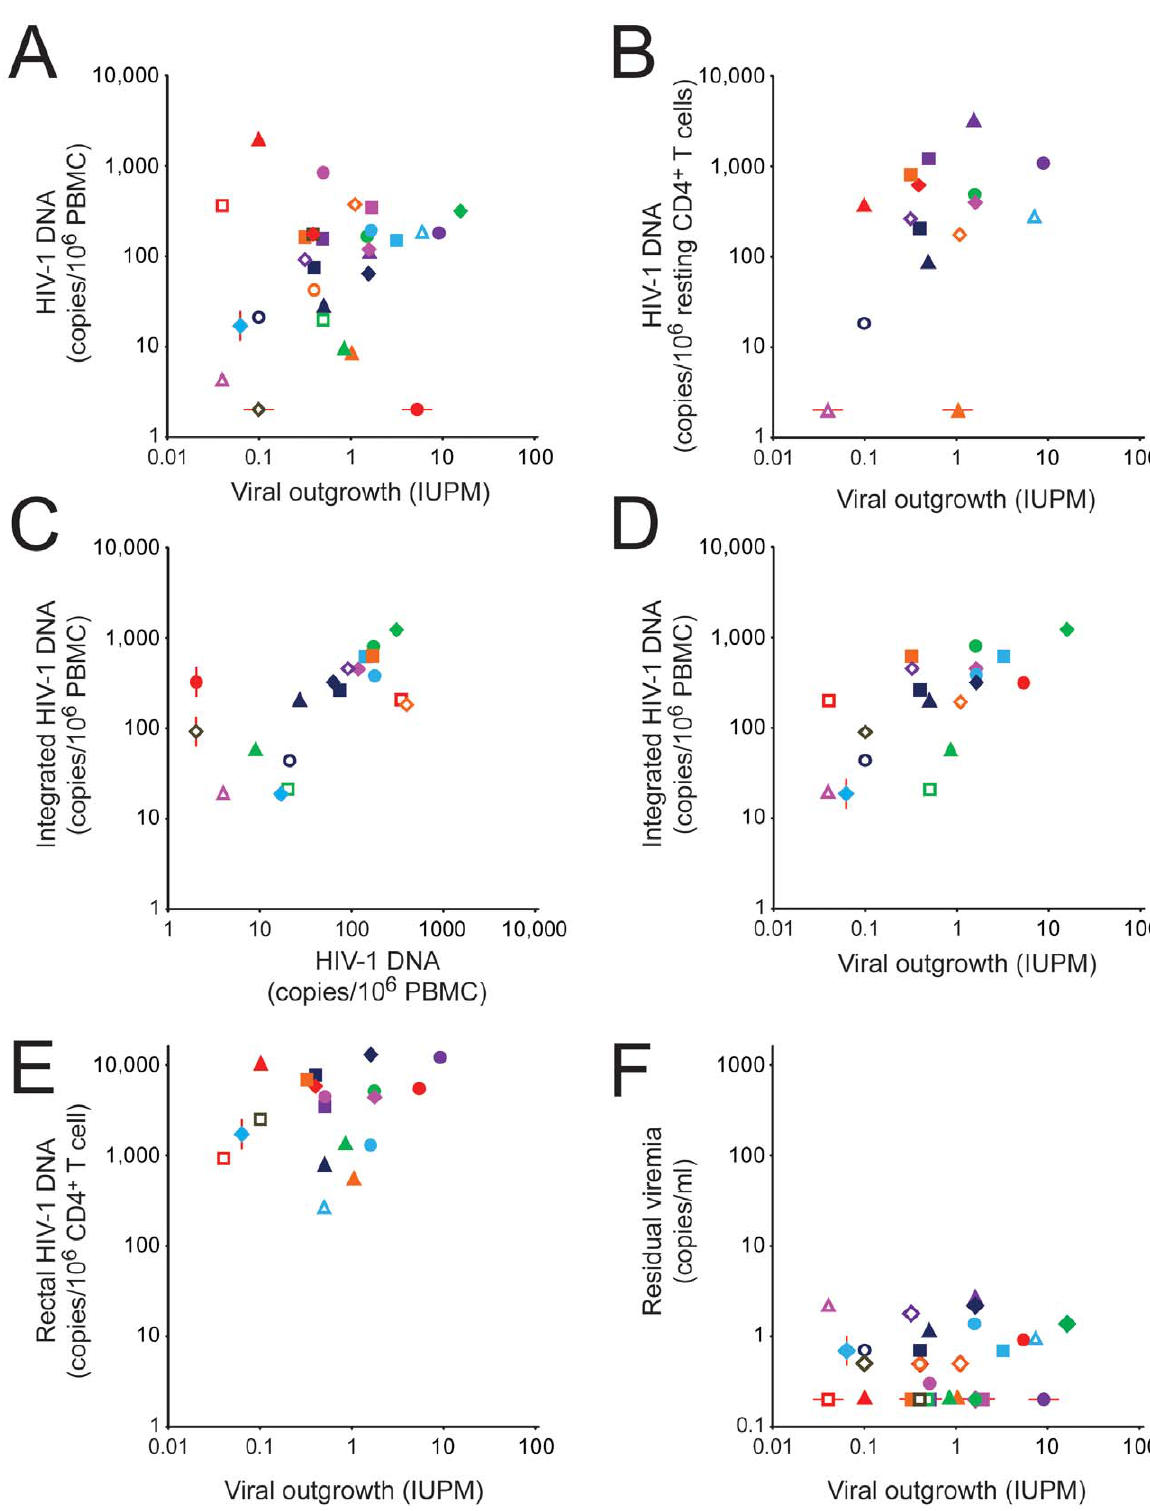
Figure 2. Correlation between assays for HIV-1-infected cells in patients on HAART. ( A ) Correlation between infected cell frequencies measured in the viral outgrowth assay on purified resting CD4 + T cells and the droplet digital PCR assay for HIV-1 DNA in unfractionated PBMC. ( B ) Correlation between the viral outgrowth assay on purified resting CD4 + T cells and the droplet digital PCR assay for HIV-1 DNA in purified resting CD4 + T cells. ( C ) Correlation between the droplet digital PCR assay for HIV-1 DNA and the Alu PCR assay for integrated HIV-1 DNA in PBMC. ( D ) Correlation between the viral outgrowth assay on purified resting CD4 + T cells and the Alu PCR assay for integrated HIV-1 DNA in PBMC. ( E ) Correlation between the viral outgrowth assay on purified resting CD4 + T cells from the blood and the PCR assay for HIV-1 DNA in rectal CD4 + T cells. ( F ) Correlation between the viral outgrowth assay on purified resting CD4 + T cells from the blood and the single copy assay for residual viremia.